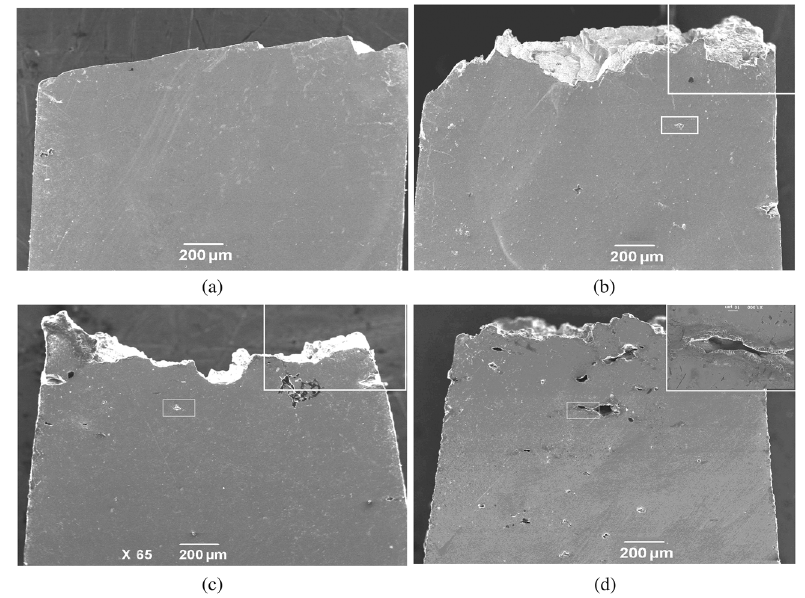
Figure 9: SEM images near fracture surface of the specimens. (a) δ = 0.3 mm and